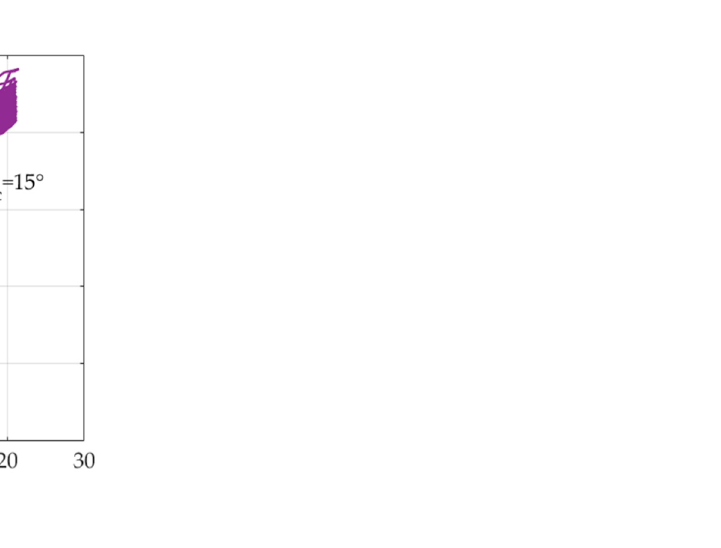
Figure 14. Relationship between orientation of accumulated strain and imposed cyclic reorientation of principal stress axes.